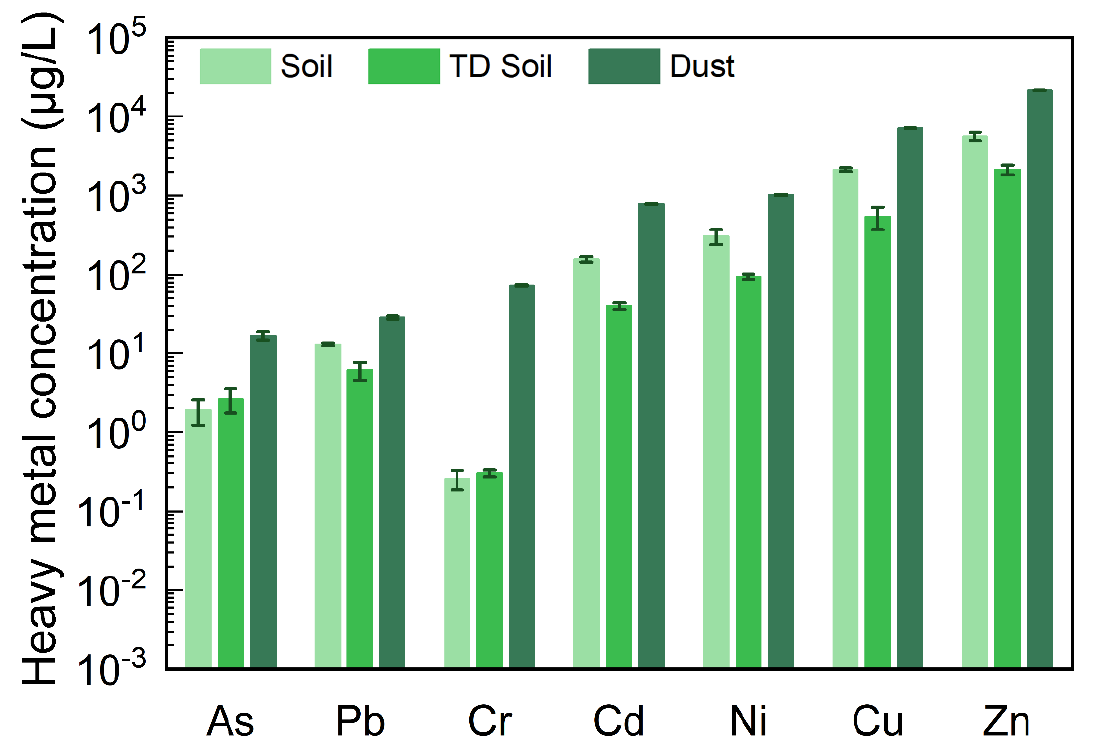
Figure 2. TCLP leaching concentrations of HMs in soil, TD soil and dust ( n = 3). The leaching concentrations of HMs, from low to high, were in the following order: As, Pb, Cr, Cd, Ni, Cu, and Zn. In soil, thermal desorption soil, and dust, the leaching concentrations of As were 1.90 µ g/L, 2.66 µ g/L, and 16.94 µ g/L, respectively; the leaching concentrations of Pb were 13.09 µ g/L, 6.11 µ g/L, and 28.53 µ g/L, respectively; the leaching concentrations of Cr were 0.25 µ g/L, 0.30 µ g/L, and 73.54 µ g/L, respectively; the leaching concentrations of Cd were 155.06 µ g/L, 39.73 µ g/L, and 782.83 µ g/L, respectively; the leaching concentrations of Ni were 305.24 µ g/L, 94.48 µ g/L, and 1015.31 µ g/L, respectively; the leaching concentrations of Cu were 2144.52 µ g/L, 542.79 µ g/L, and 7097.99 µ g/L, respectively; and the leaching concentrations of Zn were 5599.72 µ g/L, 2134.14 µ g/L, and 21,592.35 µ g/L, respectively.